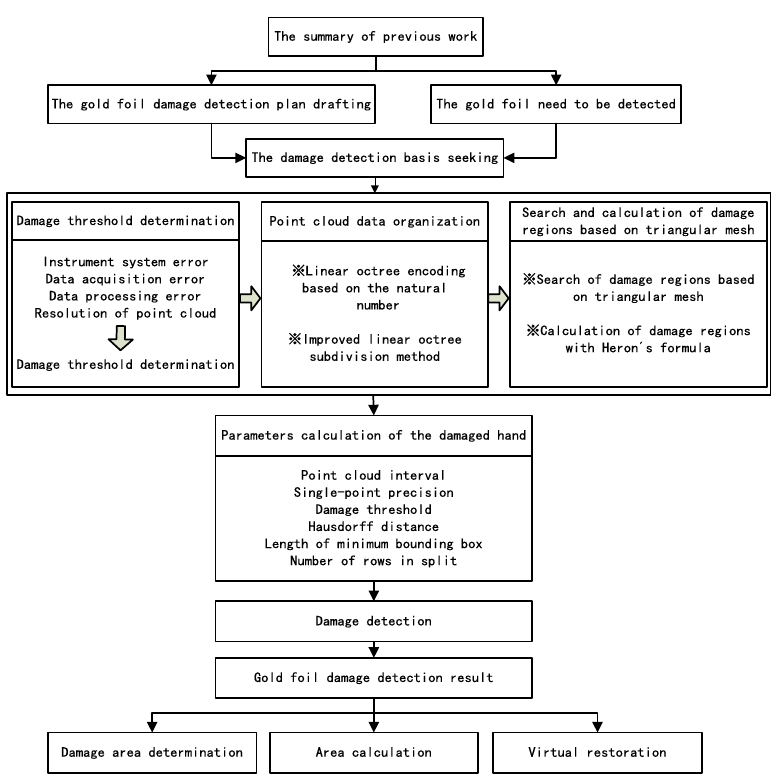
Figure 2. The overall technical process of the proposed method.